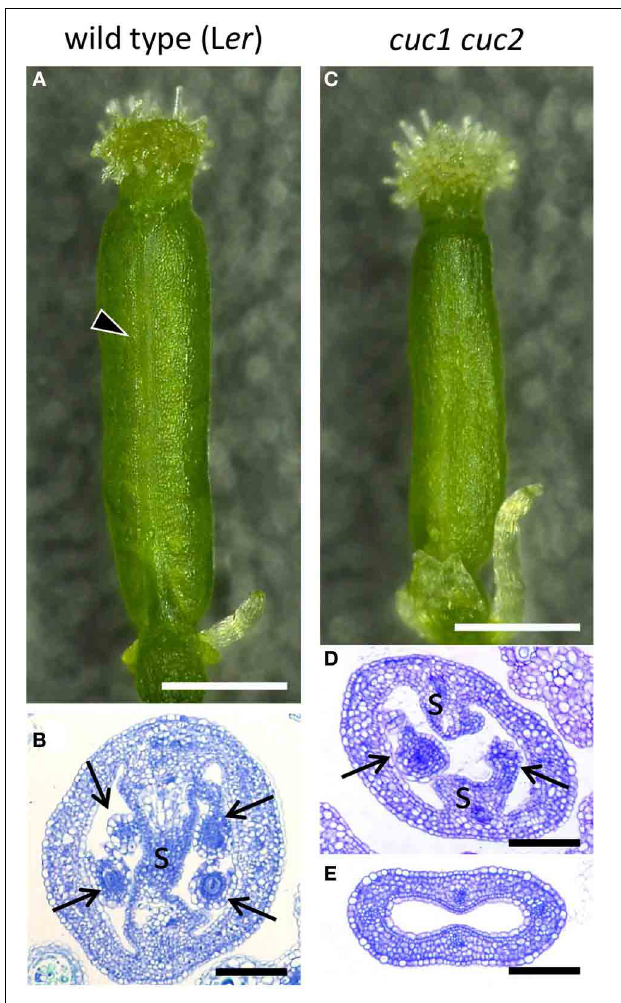
FIGURE 1 | Gynoecium phenotype of cuc1 cuc2 . Mature gynoecia from regenerated plants of wild type L er (A,B) and cuc1 cuc2 (C–E) . Whole view (A,C) and transverse sections (B,D,E) . Arrowhead in (A) indicates the replum. Arrow, ovule; s, septum. Scale bars are: (A,C) , 500 µ m; (B , D,E) , 100 µ